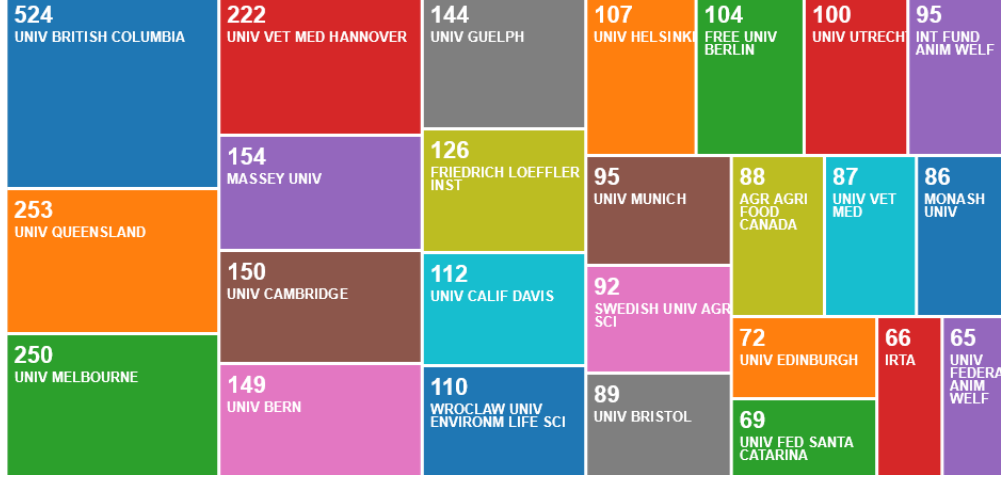
Figure 2. Number of publications per organisation, according to an online survey of publications by animal welfare centres in the Web of Science, May 2020.